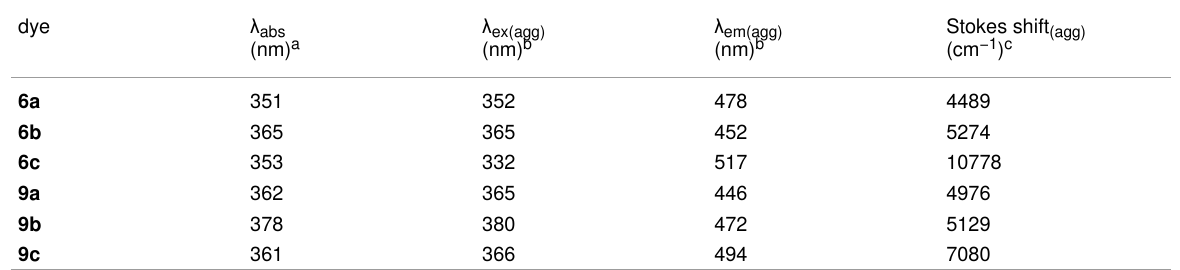
Table 2: Optical properties of BKIs and F-BKIs.